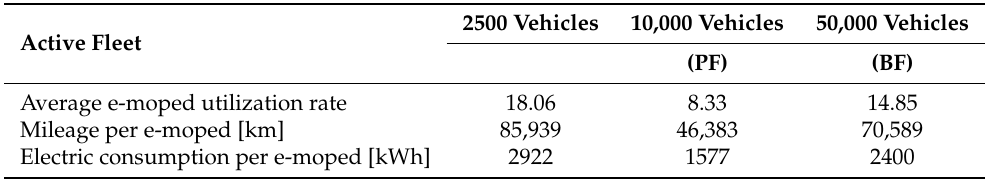
Table 12. Lifetime sharing simulation results for additional scenarios (PF—personal factor, BS—8 h battery